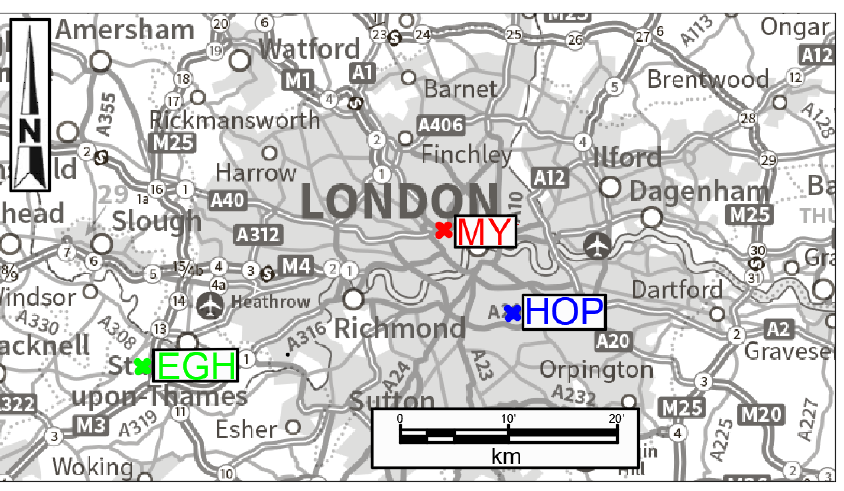
Figure 1. Locations of the Marylebone Road (MY) (Roadside), Honor Oak Park (HOP) (Background), and Egham (EGH) (Background) monitoring sites (Contains Ordnance Survey data, Crown copyright (and database right) 2021).